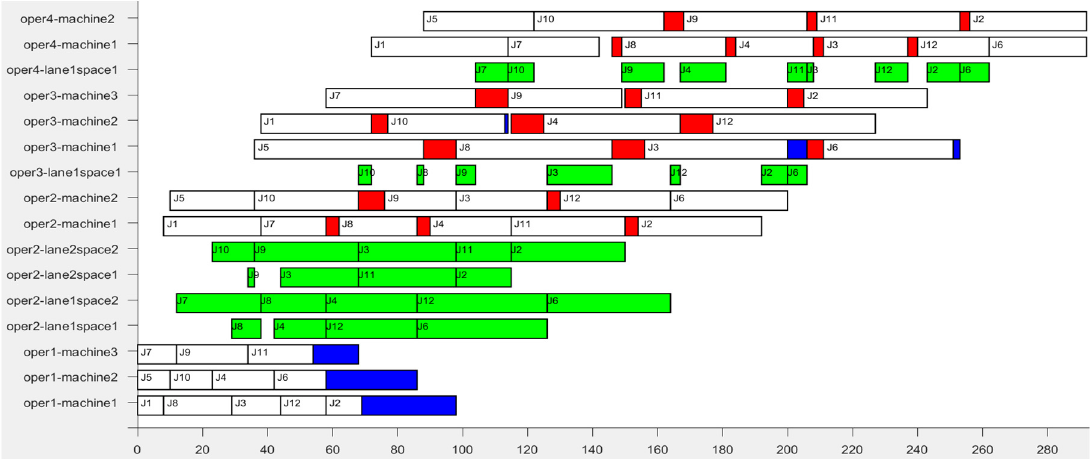
Figure 4. Gantt chart of the scheduling result of the ICGA.